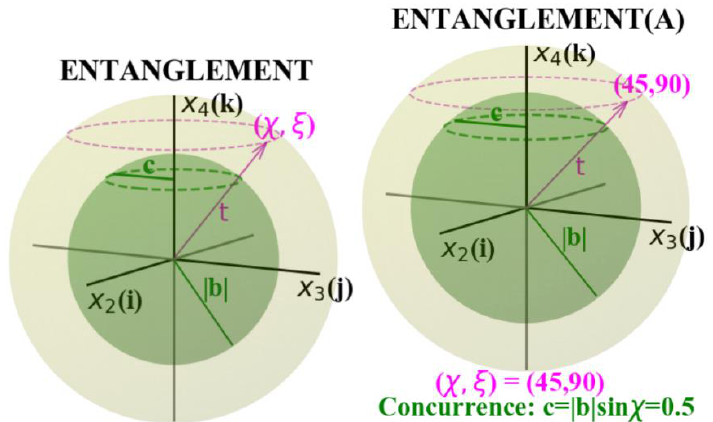
Figure 3. The improved entanglement sphere has two spheres: the outer sphere of unit radius (yellow) and the inner sphere of radius |b| (green). The pure-imaginary unit quaternion t with angular coordinates ( χ , ξ ) meets the outer sphere and the dashed magenta horizontal circle is drawn. t intersects the inner sphere where the dashed green horizontal circle of radius c , concurrence, is drawn. The z -coordinate of the green dashed circle (on the inner sphere) is the x 4 , up to the sign, of the reduced density matrix (Equation (12)). The intersection of t with the inner sphere gives the coordinate ( x 2 , x 3 , x 4 ). The sphere on the right shows an example of an entanglement sphere indicating which qubit is the base qubit (qubit-A), with values displayed for the angular coordinates and the concurrence.